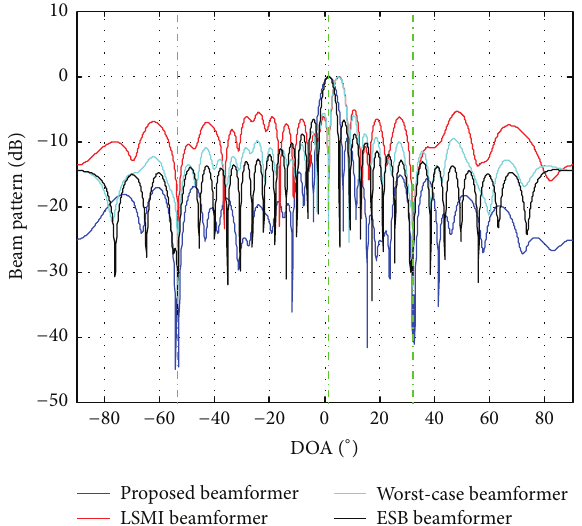
Figure1:ComparisonofthenormalizedbeampatternsinExample1 with SNR = 0 dB and 𝐾 = 60 .